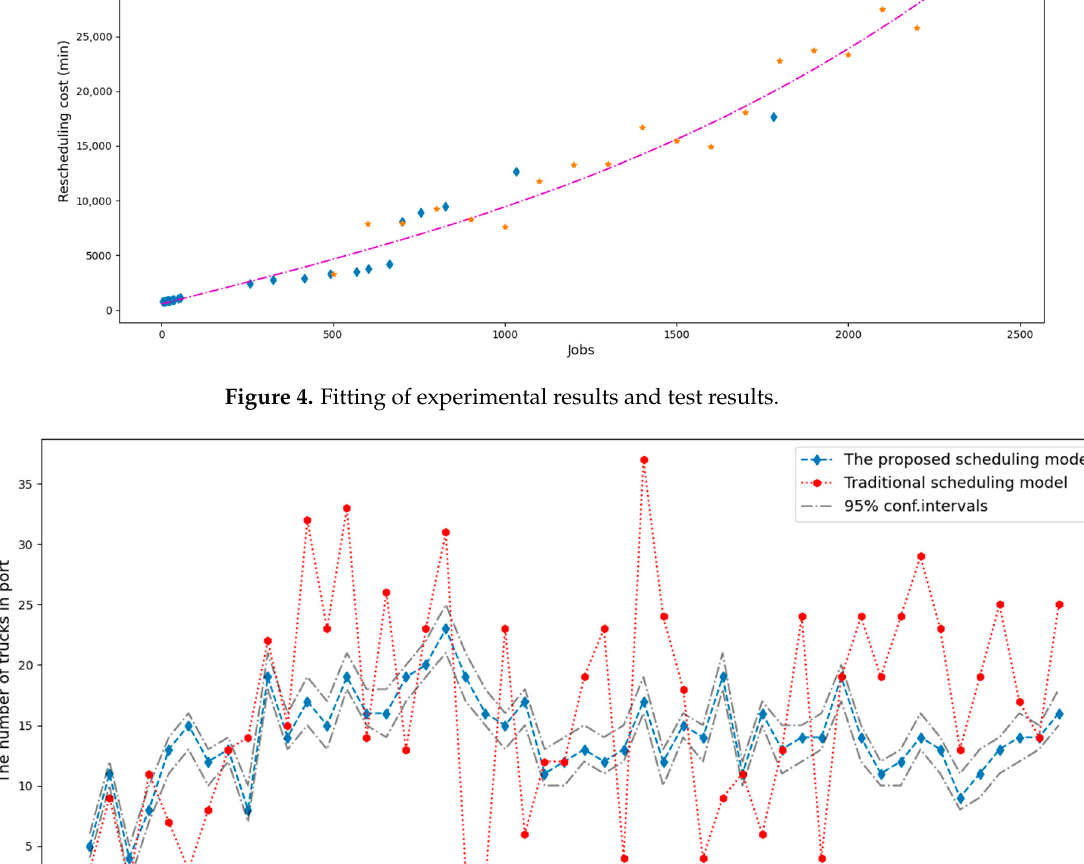
Figure 5. Changes in the number of trucks in port.